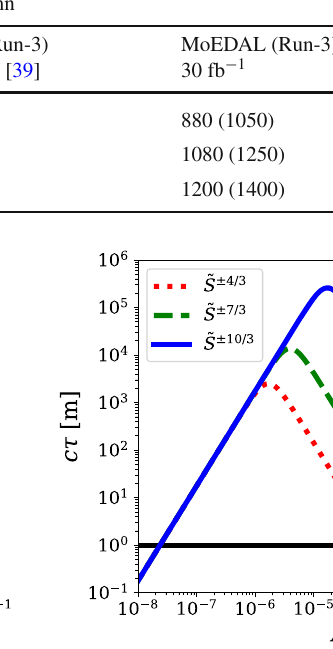
represents the projected mass reach for Run-3 (300 fb − 1 ) obtained in